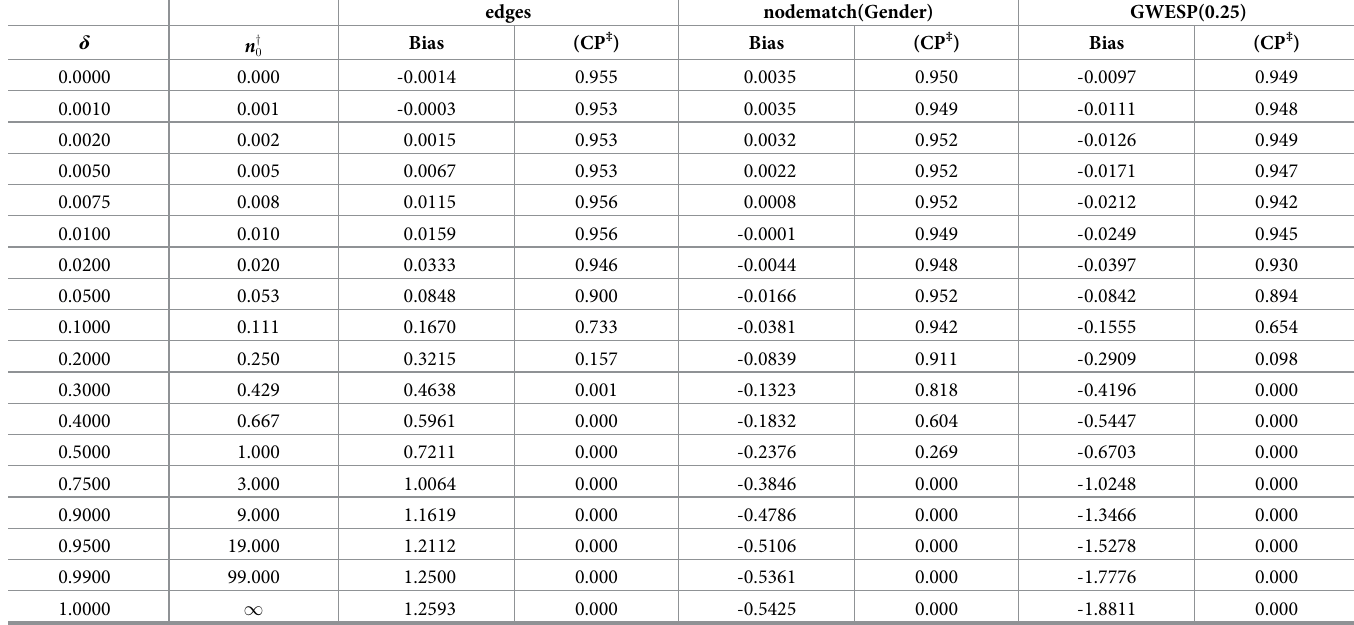
Table 3. Frequentist properties of MAP estimates and the Laplace approximation for model parameters under different relative prior weights, with sample size fixed at m = 1. edges nodematch(Gender)